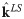
Performance assessment of the first reactionet lasso step for 105 single cell trajectories of the apoptotic receptor subunit.(A) Enrichment and depletion of true and respectively false positive reactions for the reaction rate estimates k^LS (red) and k^FG (blue). Results are reported for gradient estimation procedures smooth, FDS, splines (see main text for details). (B) Comparison of response (empirical moment gradients) and prediction with feasible generalized least square estimate for moments of different order: means (blue), variances (green), covariances (yellow) and prediction with true rate constants for all moments (red crosses).